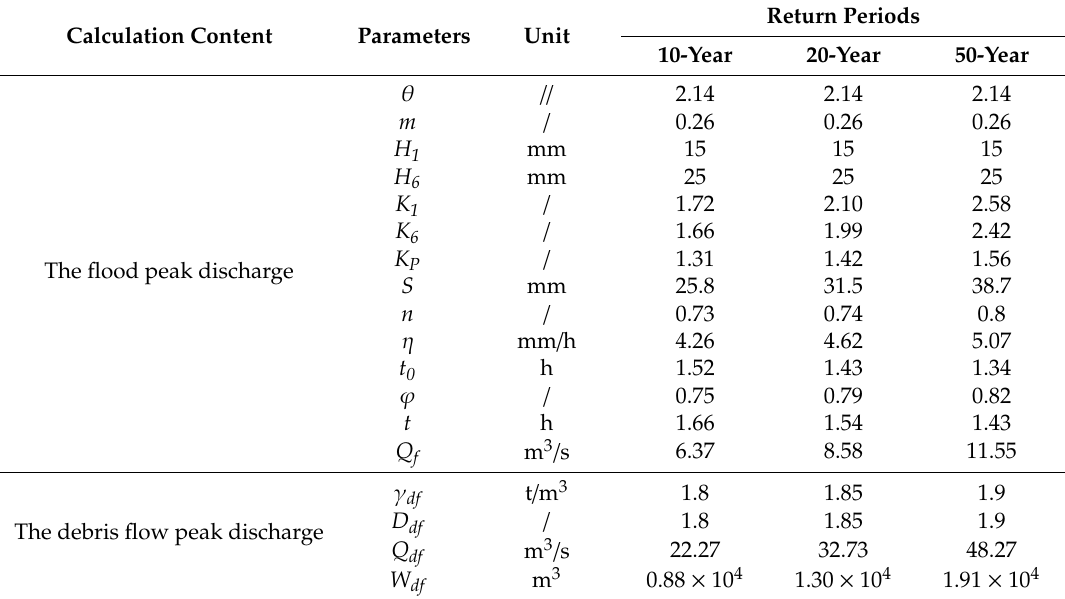
Table 4. Calculation results of the debris flow peak discharge by using the rain-flood